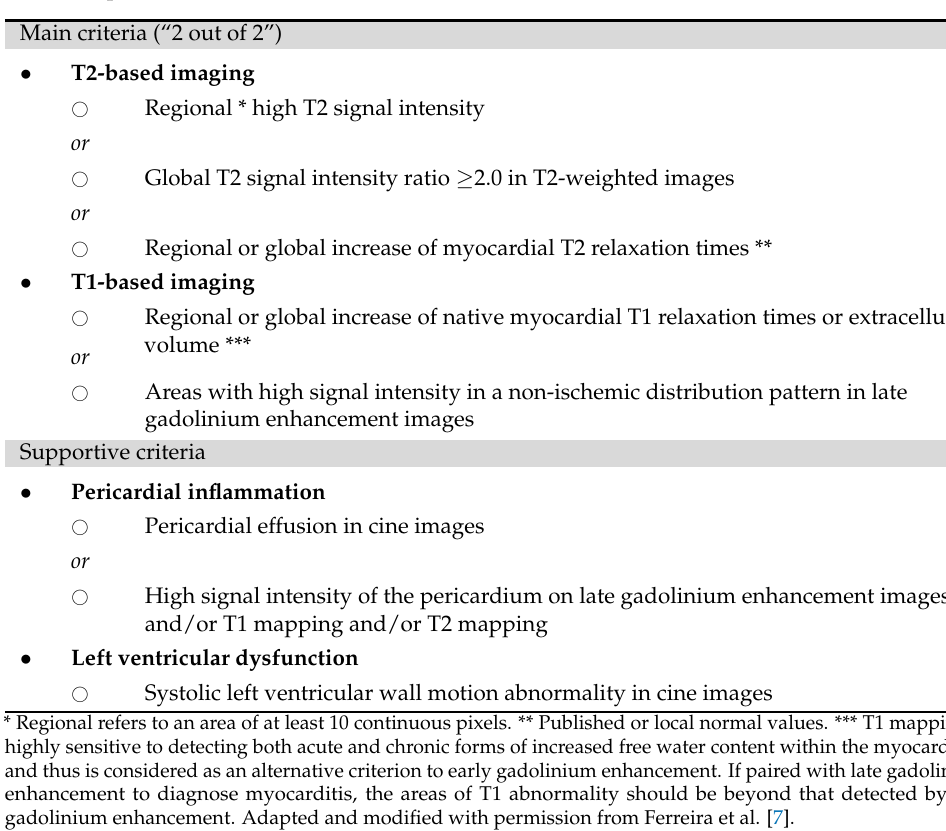
Table 3. Updated Lake Louise